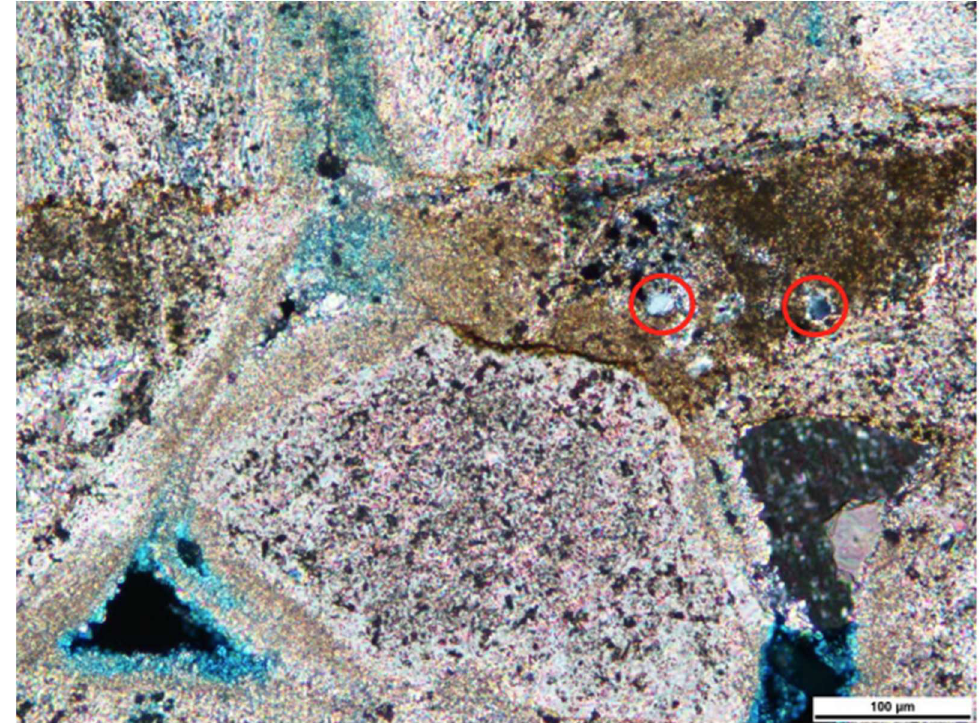
Figure 1. Field of view: 0.62 mm, cross-polarized limestone sample. Very-fine grained quartz is included in inclusion-rich fragments. Holes are highlighted by the blue epoxy used in thin section preparation. Red circles reveal smaller grains closer to the respirable size range.